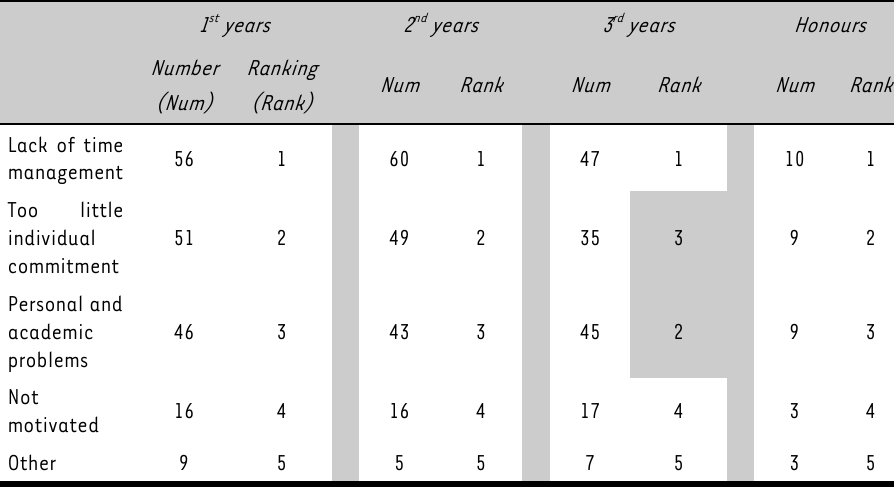
Factors hindering own success split between academic